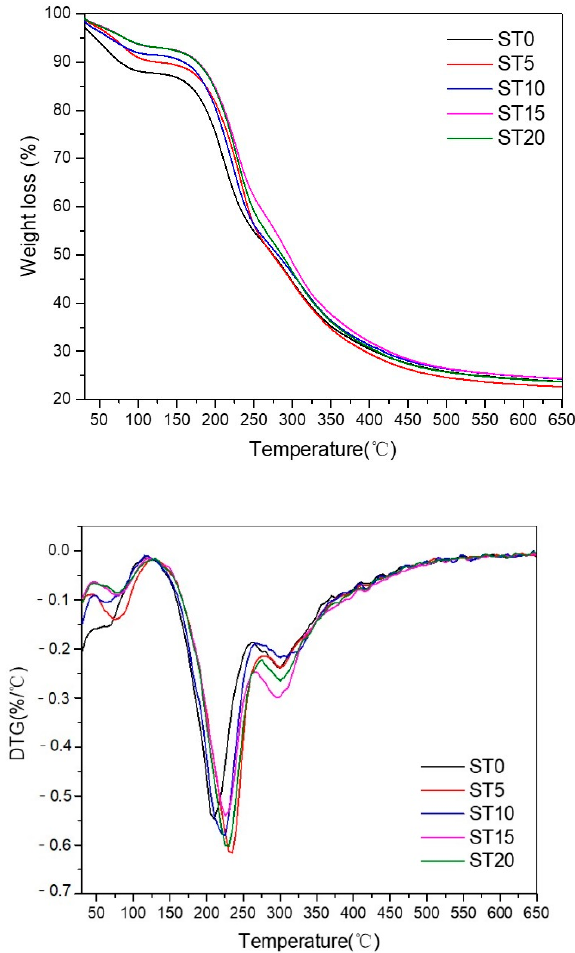
Figure 4. TGA and corresponding DTG traces of SPI and SPI–BT films.